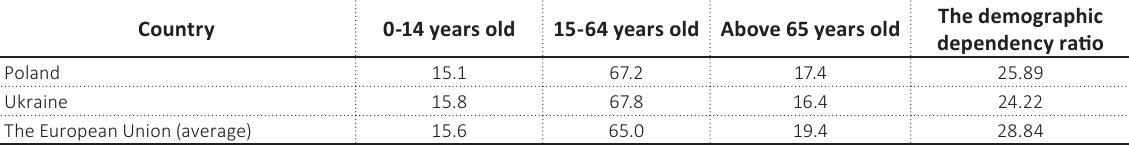
Table 2. Aging of the populace (in %) and the demographic dependency ratio of the pensioners in Poland and Ukraine in comparison to the European average